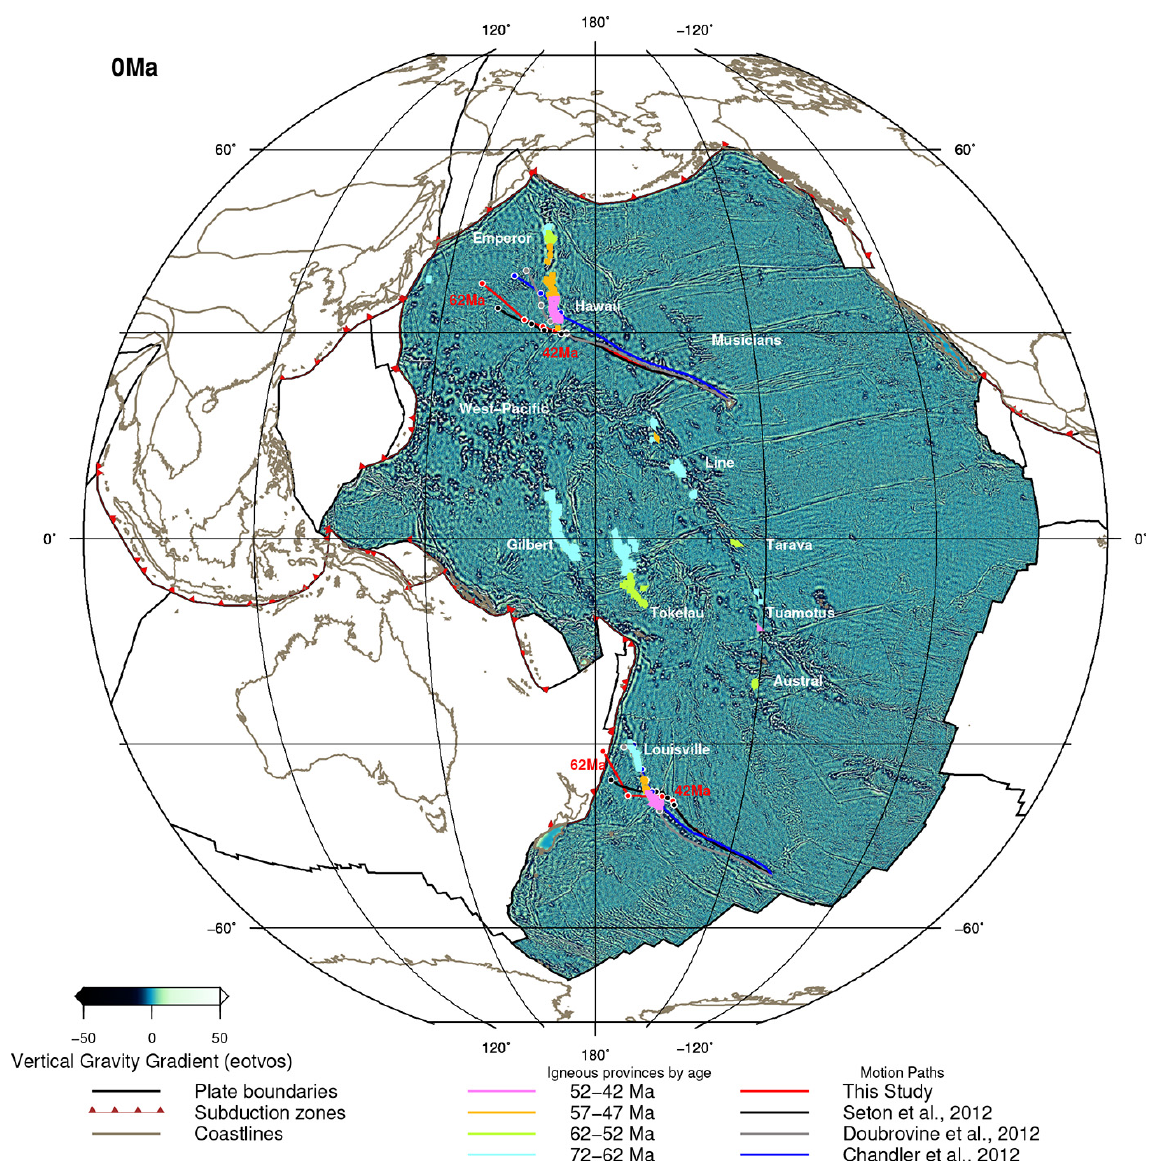
Figure 7. Present-day vertical gravity gradient of the Pacific plate (Sandwell and Smith, 2009). Present-day locations of volcanics dated between 72 and 42Ma are binned in 10Myr increments and coloured as in the legend. The computed motion paths for fixed Hawaiian and Louisville hotspots are shown back to 62Ma, for each of the different models, as listed in the legend. Dots along the motion path show the trail’s position at 42, 47, 52, and 62Ma